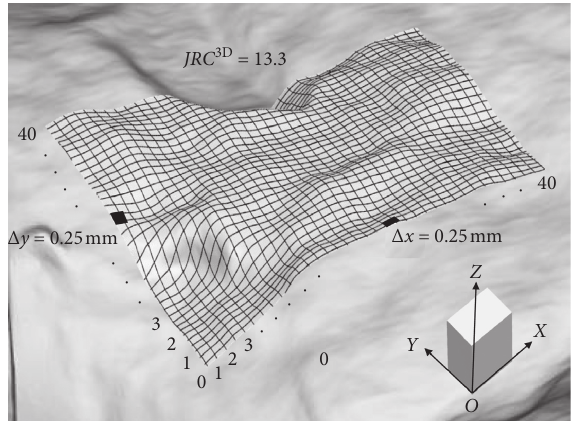
Figure 9: 3D roughness of the contour surface of the aggregate. Table 9: The change in the roughness with increasing polishing time.